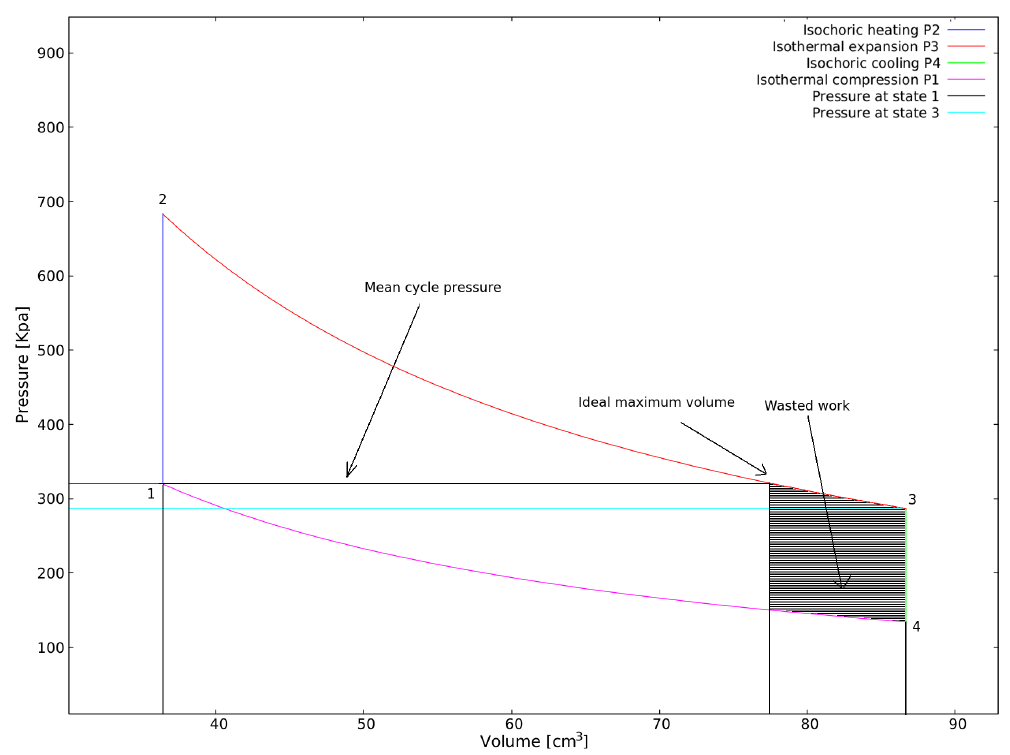
Figure 7. The proposed beta engine has a CR too big for the applied ∆ T